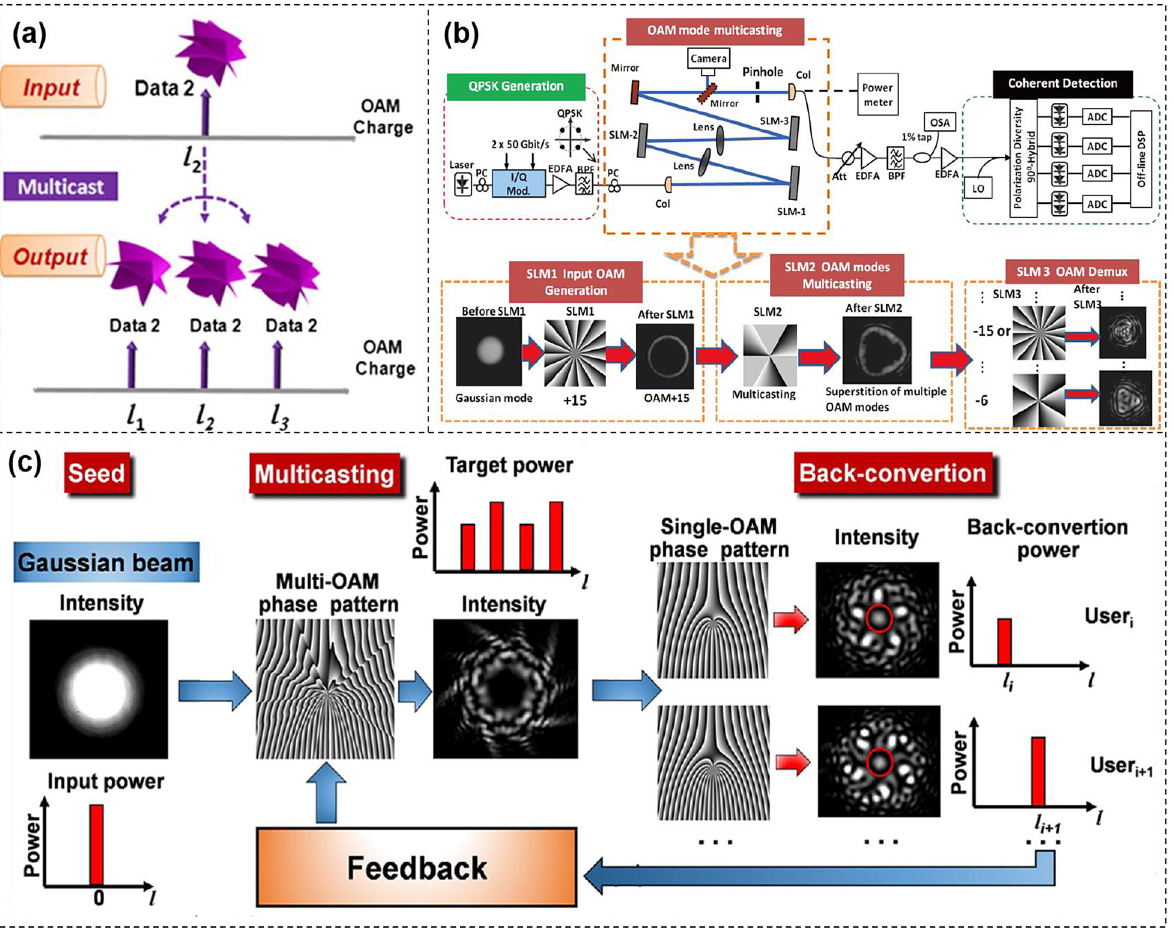
Figure 13: Power-equalized and adaptive power-controllable OAM multicasting. (a) Concept of OAM multicasting [96]. (b) Power-equalized spatial-mode multicasting of a single 100-Gbit/s QPSK carrying OAM beam onto multiple OAM beams [97]. (c) Concept of feedback-assisted adaptive power-controllable OAM multicasting [98]. Reprint permission obtained from [96 –